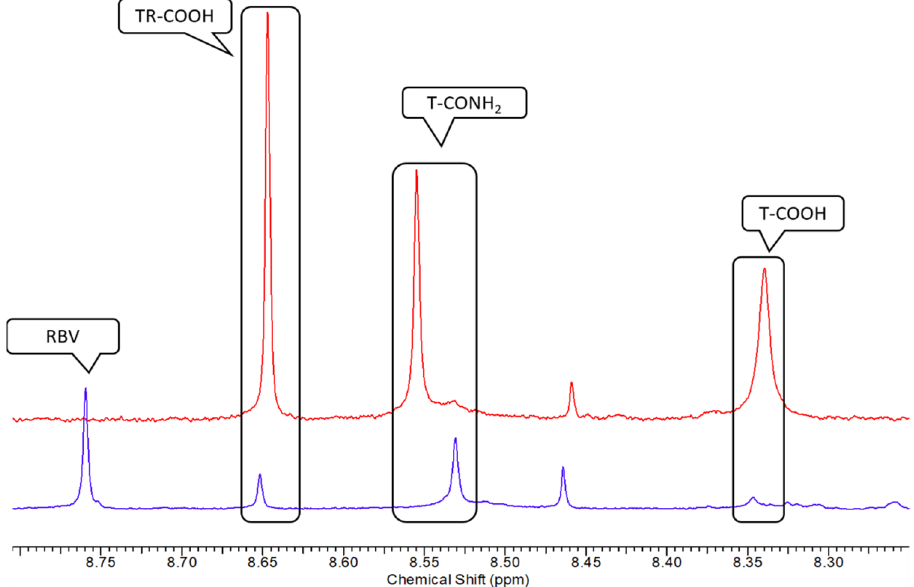
Figure 6. From the bottom to the top, 1 H NMR urine aromatic region of an HCV patient at TW4 stage (blue) and a control spiked with TR-COOH, T-CONH 2 , and T-COOH (red). Small variations in chemical shift can be attributed to the different ionic strengths and the small variation in pH in the urine sample.